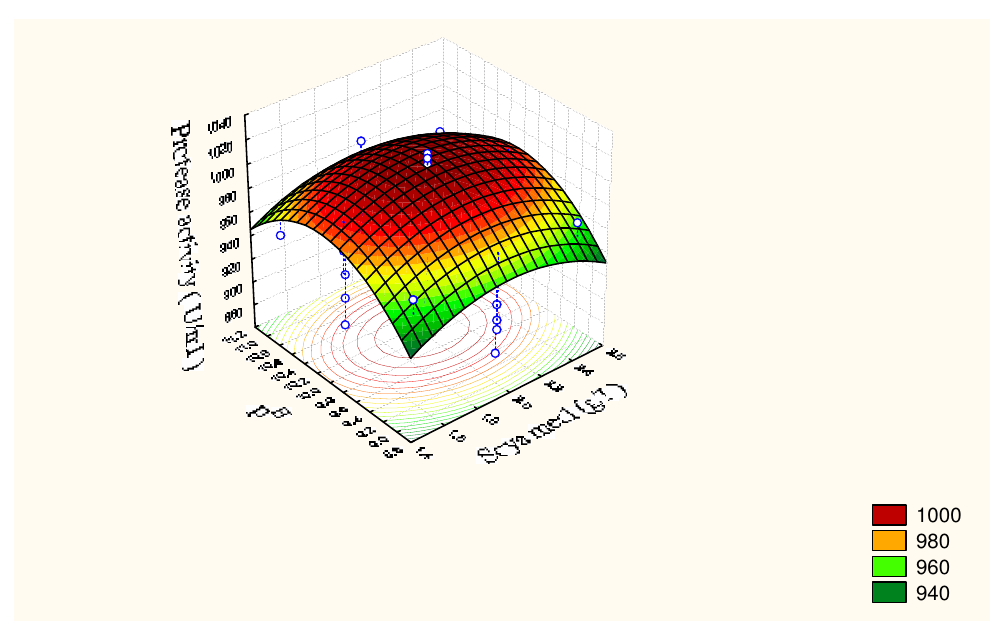
Figure 3(f). Effect of Soya meal & pH on protease